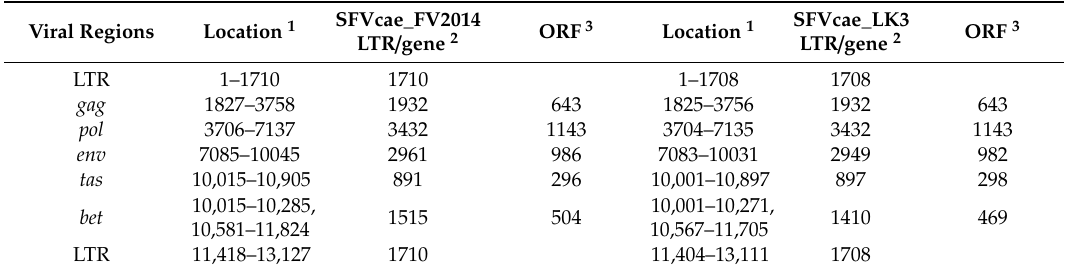
Table 3. Comparison of genomic structures of SFVcae